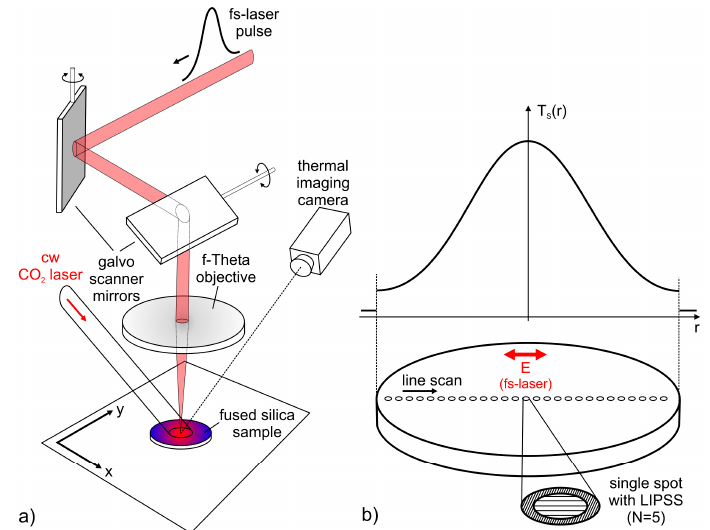
Figure 1. ( a ) Experimental setup and ( b ) generation of laser-induced periodic surface structures (LIPSS) at different substrate temperatures, T S ( r ), that depend on the radial position on the sample. Parameters of the fs-laser were τ = 300 fs (FWHM), λ = 1025 nm, E imp ≤ 40 µJ, and f rep = 1 kHz.